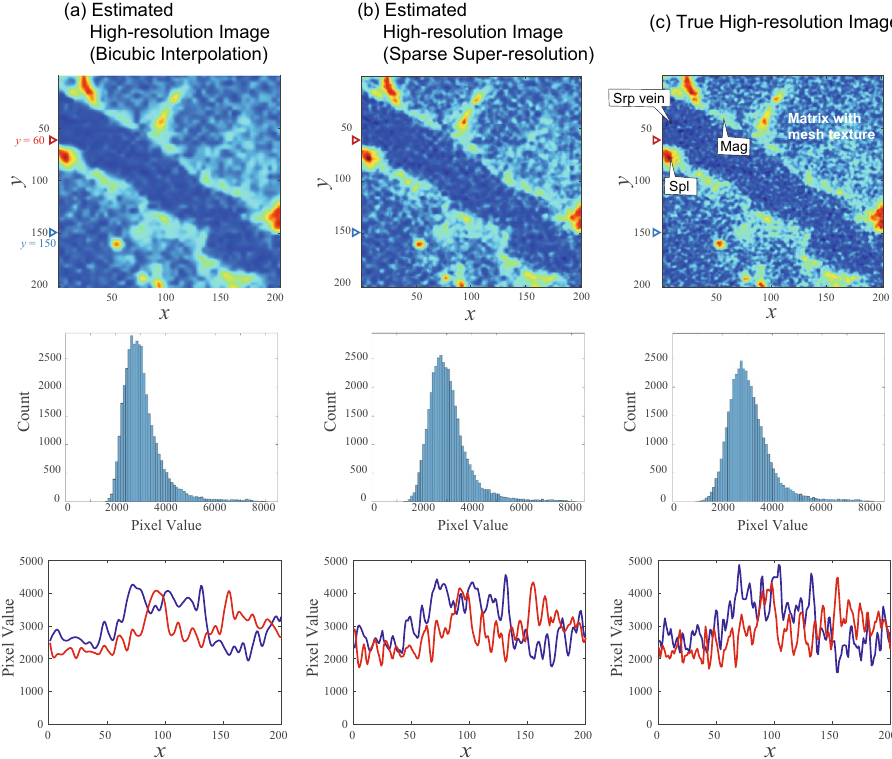
Figure 4. Top: high-resolution images estimated by existing and proposed methods. Fine structures seen in true image ( c ) is reconstructed by the proposed method ( b ), whereas a simplified image ( a ) is obtained by means of the existing method. Middle: histograms of pixels in the two dimensional area of image). Bottom: pixel values as a function of position x for a fixed value of y [ y = 60 (red line), and y = 150 (blue line)]. Srp serpentine, Spl spinel, Mag magnetite. Voxel size of the high-resolution image was 10 µ m